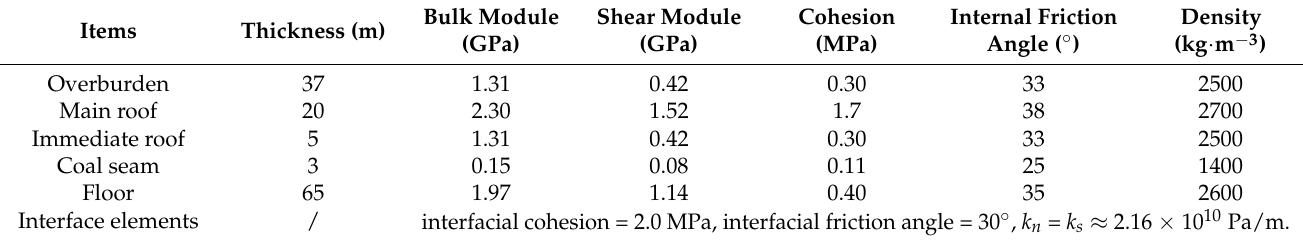
Table 2. Model mechanical parameters and thickness of the fault and strata. /: The interface elements do not have thickness